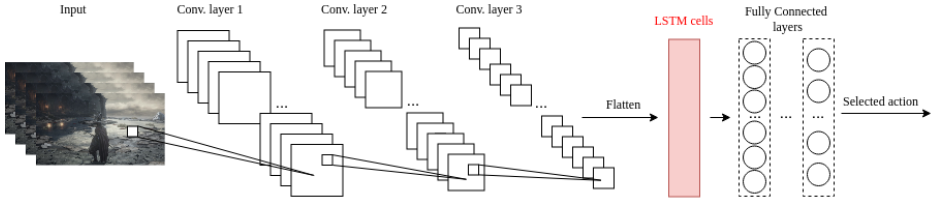
Figure 3. Architectural overview of the models implemented as baselines. The black components are part of both models, while the red LSTM cells are included only in the DRQN